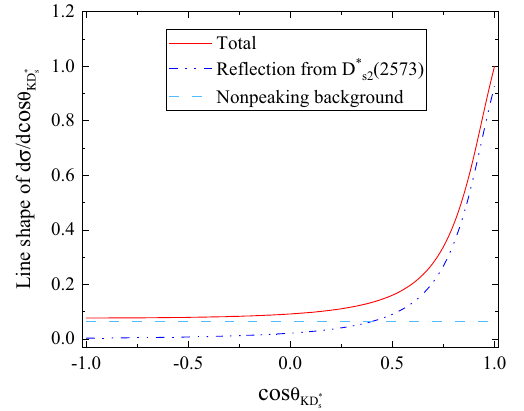
Fig. 3 Thepredictedlineshapeofdifferentialcrosssectionof e + e − → D 0 K + D ∗− s vs. cos θ KD ∗